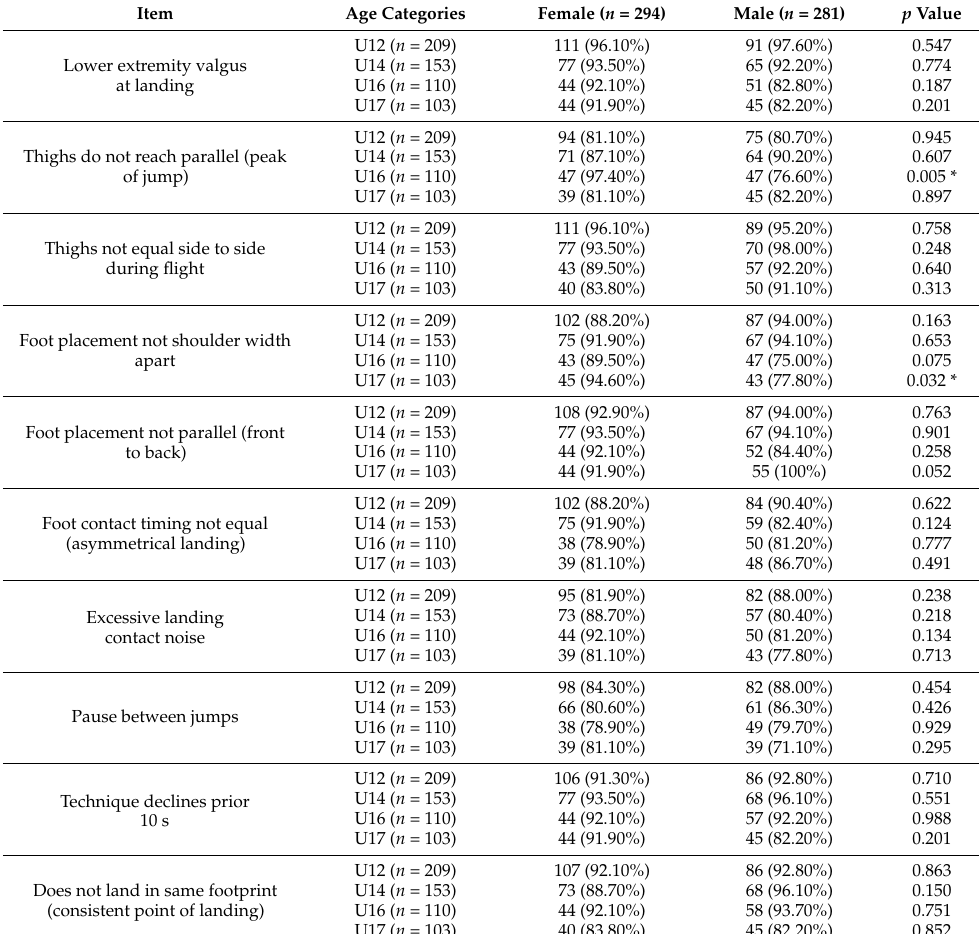
Table 6. Modified tuck jump assessment for between-group comparisons of U12 to U17 basketball